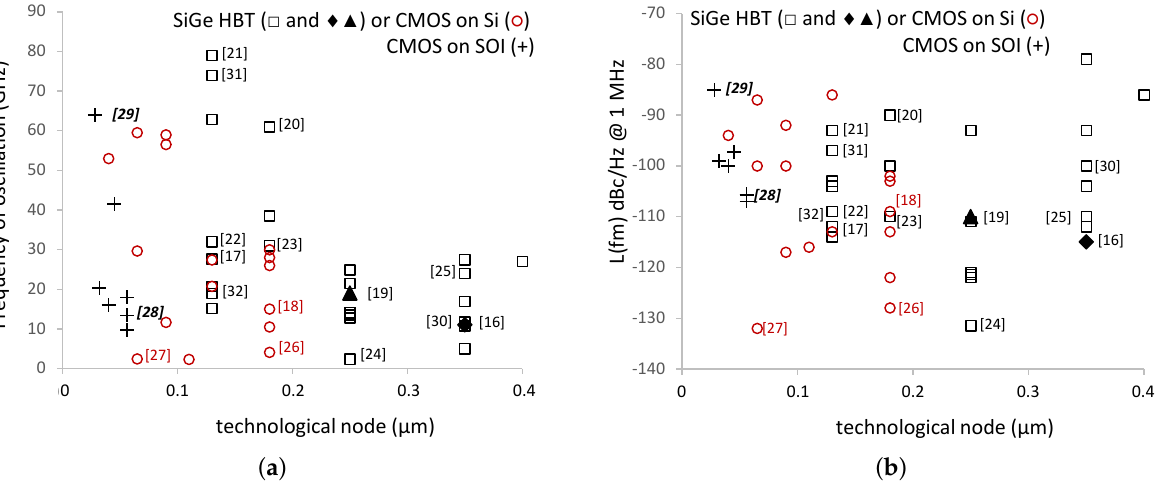
Figure 7. Evolution of the MMICs VCO oscillation frequencies ( a ) and Leeson’s factor ( b ) ver- sus the technological node. Some references used in the paper are noted close to the associated symbol